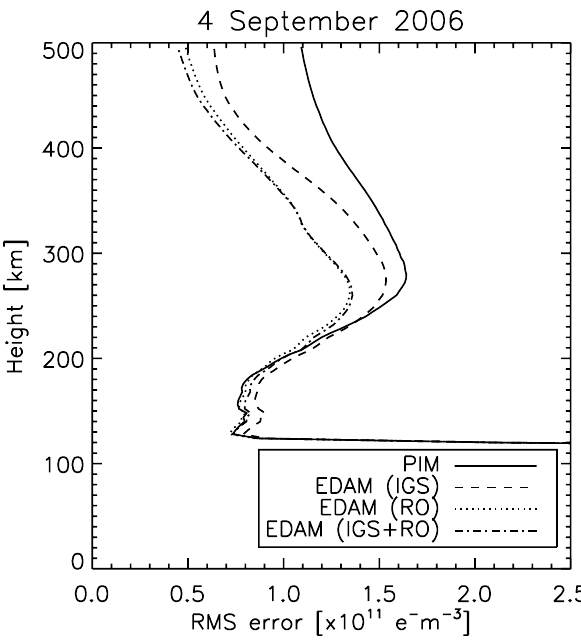
Fig. 10. RMS error between ionospheric models and Abel trans- form vertical profiles at 5km height steps on 19–20 August 2006 (disturbed geomagnetic conditions). The models are: PIM (solid line); EDAM assimilating IGS data only (dashed line); EDAM as- similating COSMIC RO data only (dotted line); and EDAM assim- ilating IGS and COSMIC RO data (dot-dash